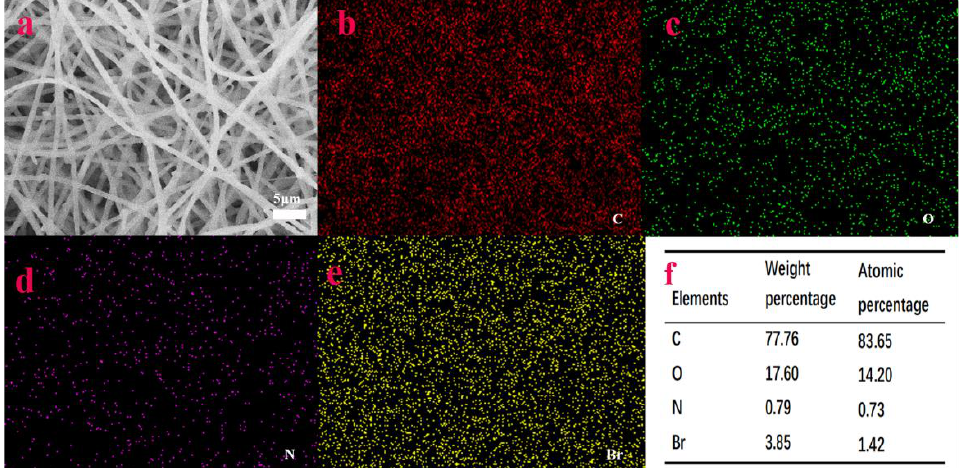
Figure 4. ( a ), Scanned images of the PCL/PEO/CS/CTAB 0.2 composite structure; ( b – e ), elemental mapping of C/O/N/Br; ( f ), table of the elemental composition of C/O/N/Br.